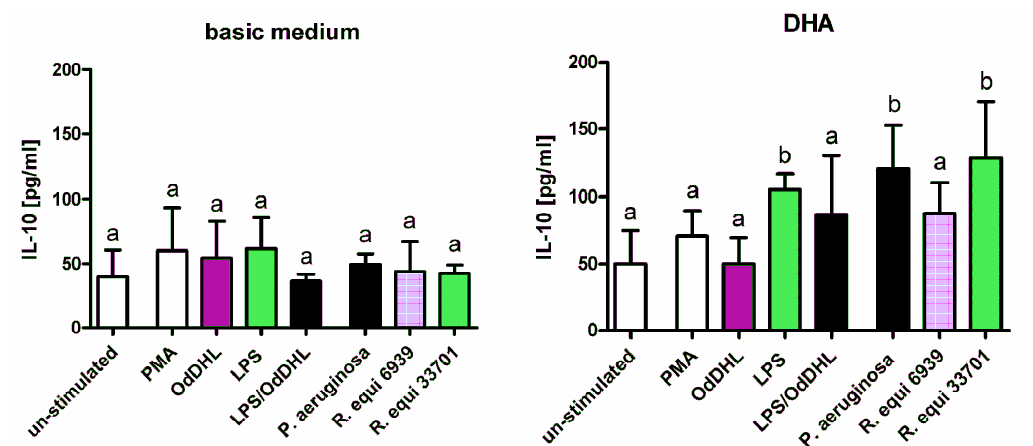
Figure 5. Concentration of IL-10 in supernatants of RAW264.7 macrophages cultured in basic medium as well as in medium supplemented with 15 µmol/L docosahexaenoic acid (DHA) after 24 h of stimulation with LPS, PMA, P. aeruginosa ATCC 10145, R. equi ATCC 6939 and R. equi ATCC 33701 respectively. Data are mean ± SD ( n = 6). Bars denoted by different letters are significantly